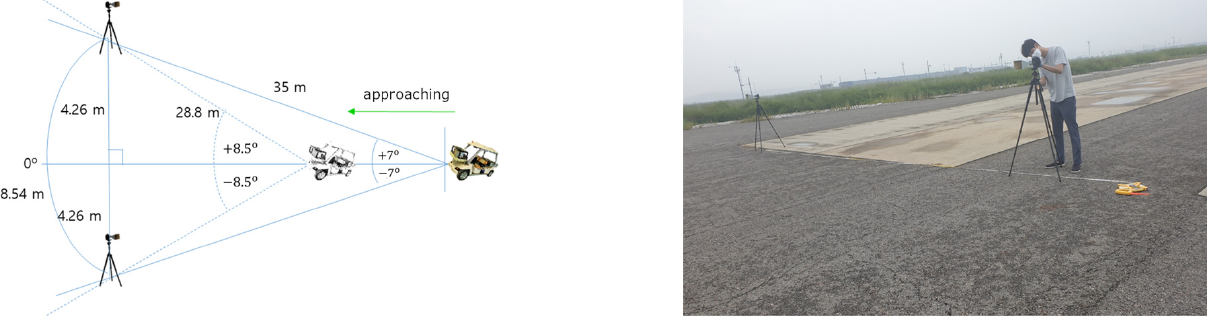
Figure 23. Test setup for measuring the angular resolution.